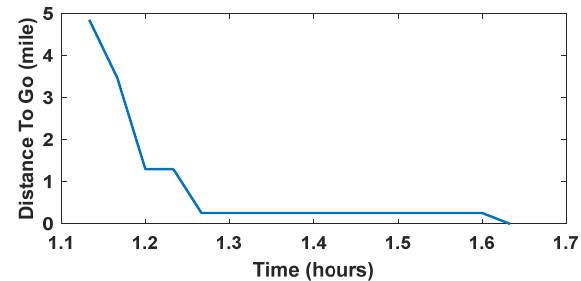
Figure 6. Distance that a specific person drove vs. time.